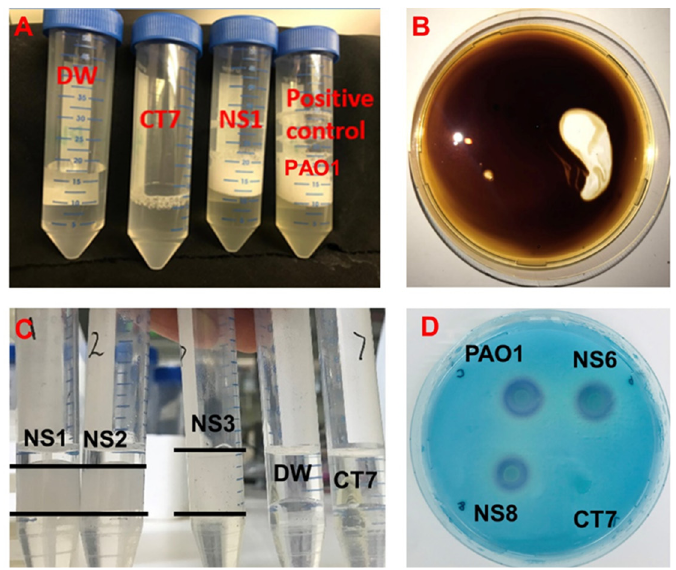
Figure 1. Biosurfactant detection by the isolated strains. ( A ) The initial screen of the strains in BH culture broth; potential biosurfactant-producing strains produced foams. ( B ) Positive results in the oil spread test; 10 µL cell-free culture broth was added onto the crude oil layer on the surface of the water. When the diameter of the clear zoon is more than 5 mm, the oil displacement activity is positive. ( C ) Emulsified height in the emulsification test. ( D ) CTAB agar plates with four well, each added with 10 µL culture medium. The blue halo area indicated the production of anionic glycolipid biosurfactant by the colonies. Table 1. Biosurfactant-activity screening